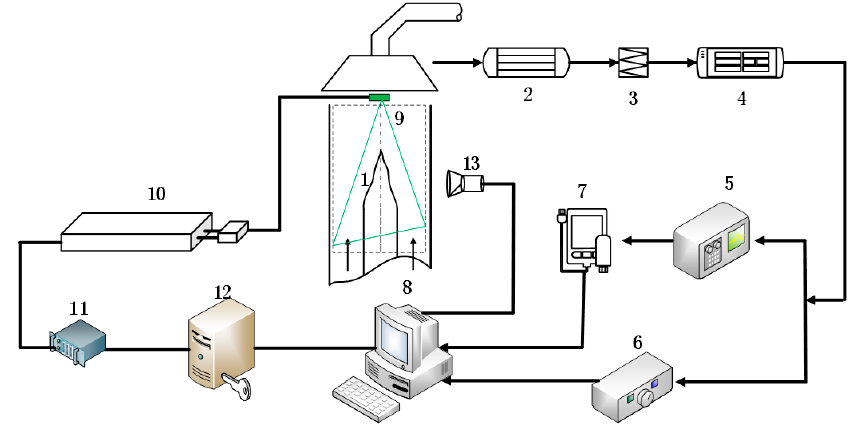
Figure 2. Schematic diagram of the experimental setup used for measurements (1. Flame; 2. Insulation pipe; 3. Filter; 4. Preprocessor; 5. Photon flue gas analyzer; 6. NOx Analyzer; 7. Data Acquisition; 8. Computer; 9. Laser; 10. Laser generator; 11. Synchronizer; 12. Controller; 13. Camera). Table 1. Measurement range and measurement accuracy of the gas analyzer for different gas components.